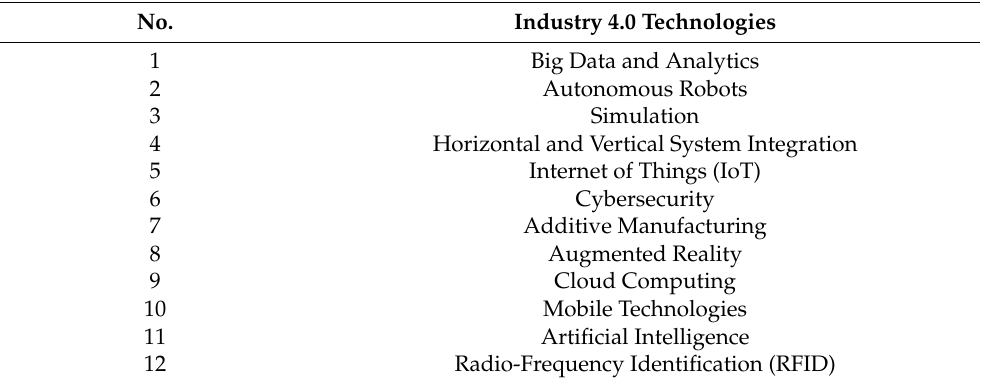
Table 2. Survey items and scale.